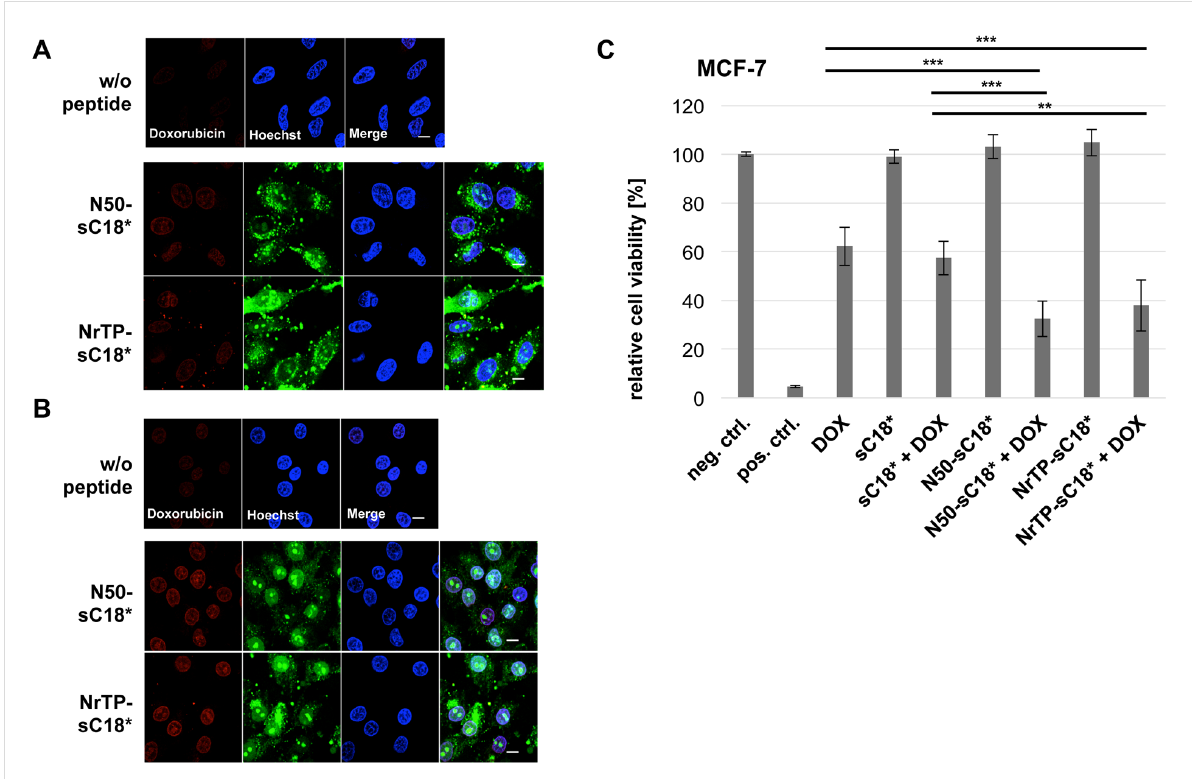
Figure 7: Uptake and delivery of DOX into HeLa and MCF-7 cells. Fluorescence microscopic images after 30 min incubation in HeLa (A) and MCF-7 (B) cells with 10 μ M CF-labeled peptides N50-sC18* or NrTP-sC18* co-incubated with 10 μ g/mL doxorubicin at 37 °C, respectively. Cells treated with DOX alone served as negative control; Green: CF-labeled peptide; blue: Hoechst 33342 nuclear stain; red: doxorubicin; scale bar is 10 µm. (C) Cells were incubated for 48 h with DOX (1 µg/mL), or solutions out of peptides (10 µM) and DOX (1 µg/mL), or peptide solutions (10 µM) alone. Untreated cells served as negative control, cells treated for 10 min with 70% ethanol as positive control. Experiments were conducted in triplicate with n = 2